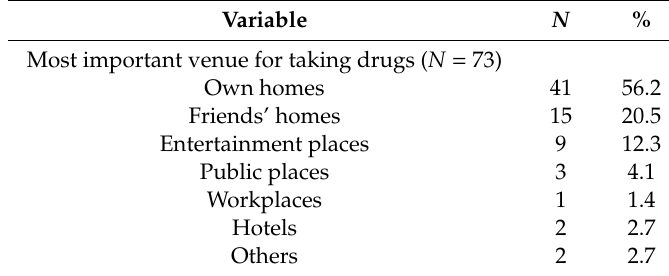
Table 2. Venues for drug